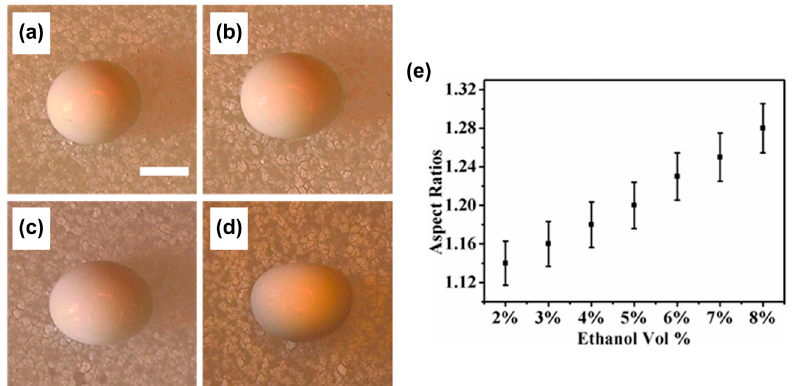
Figure 11. Optical microscopy of anisometric photonic crystals (PC) obtained by using mixtures of water and ethanol with varying compositions: ( a ) 2, ( b ) 4, ( c ) 6 and ( d ) 8 vol% of EtOH; scale bars are 800 µm. The systematic dependency of aspect ratios, i.e., anisometry values, is given in ( e ). Adapted with permission from [109] (p. 22647). Copyright 2015 American Chemical Society.